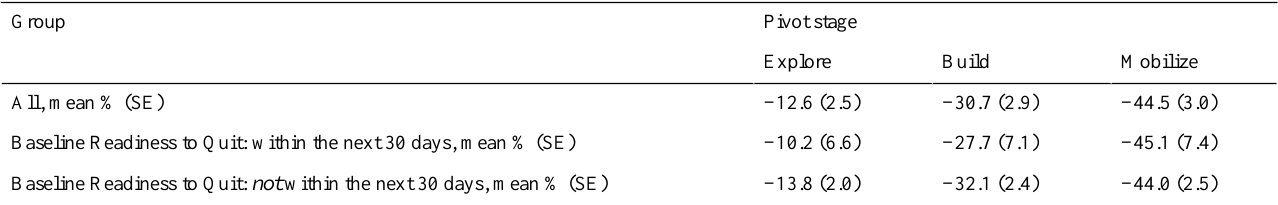
Table 6. Average percentage change in cigarettes per day (CPD) by pre-Quit stage, repeated measures linear mixed model